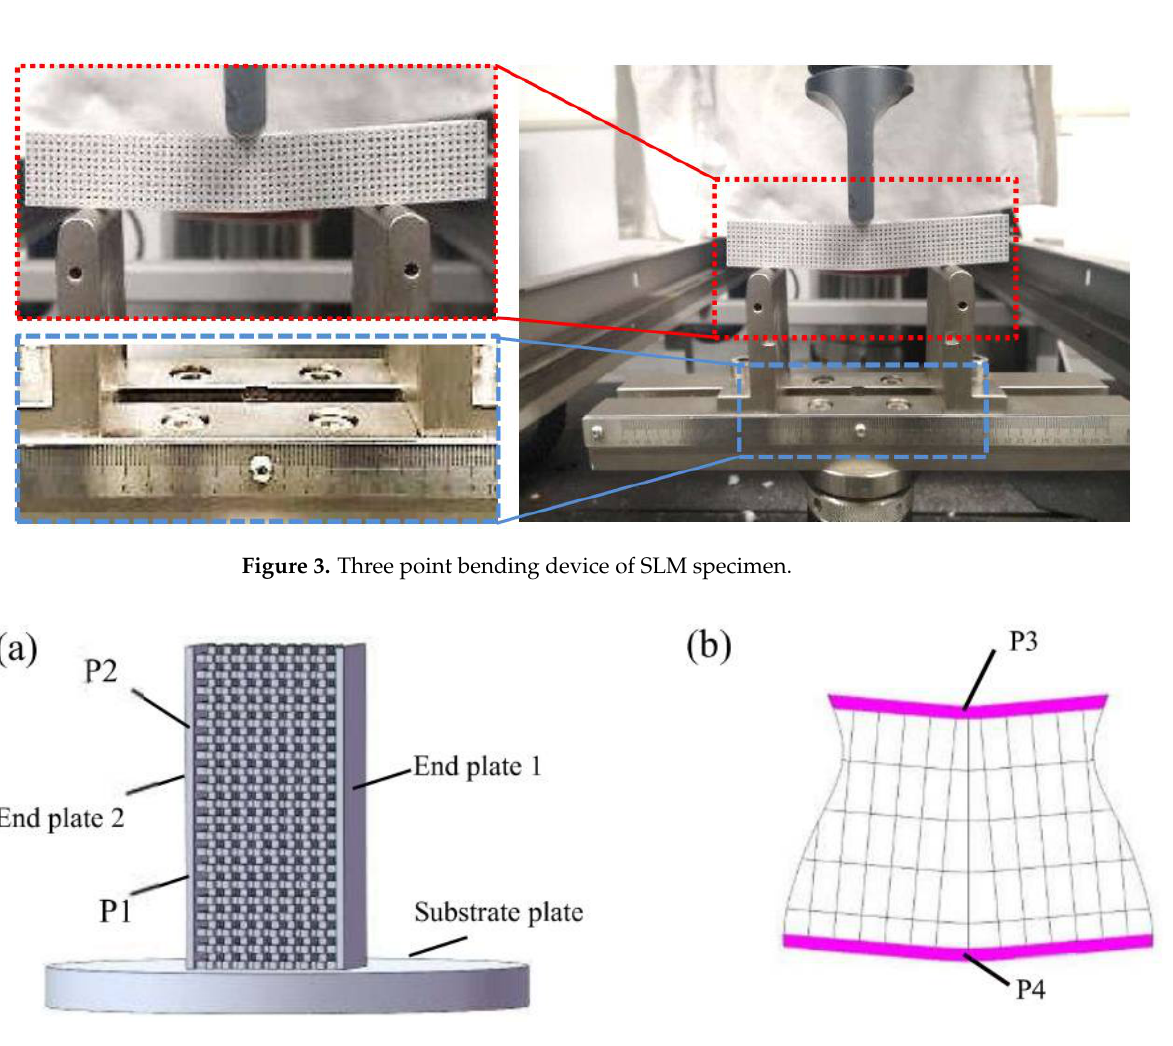
Figure 4. Schematic diagram of EBSD specimen: ( a ) unbent sample; ( b ) bent sample.